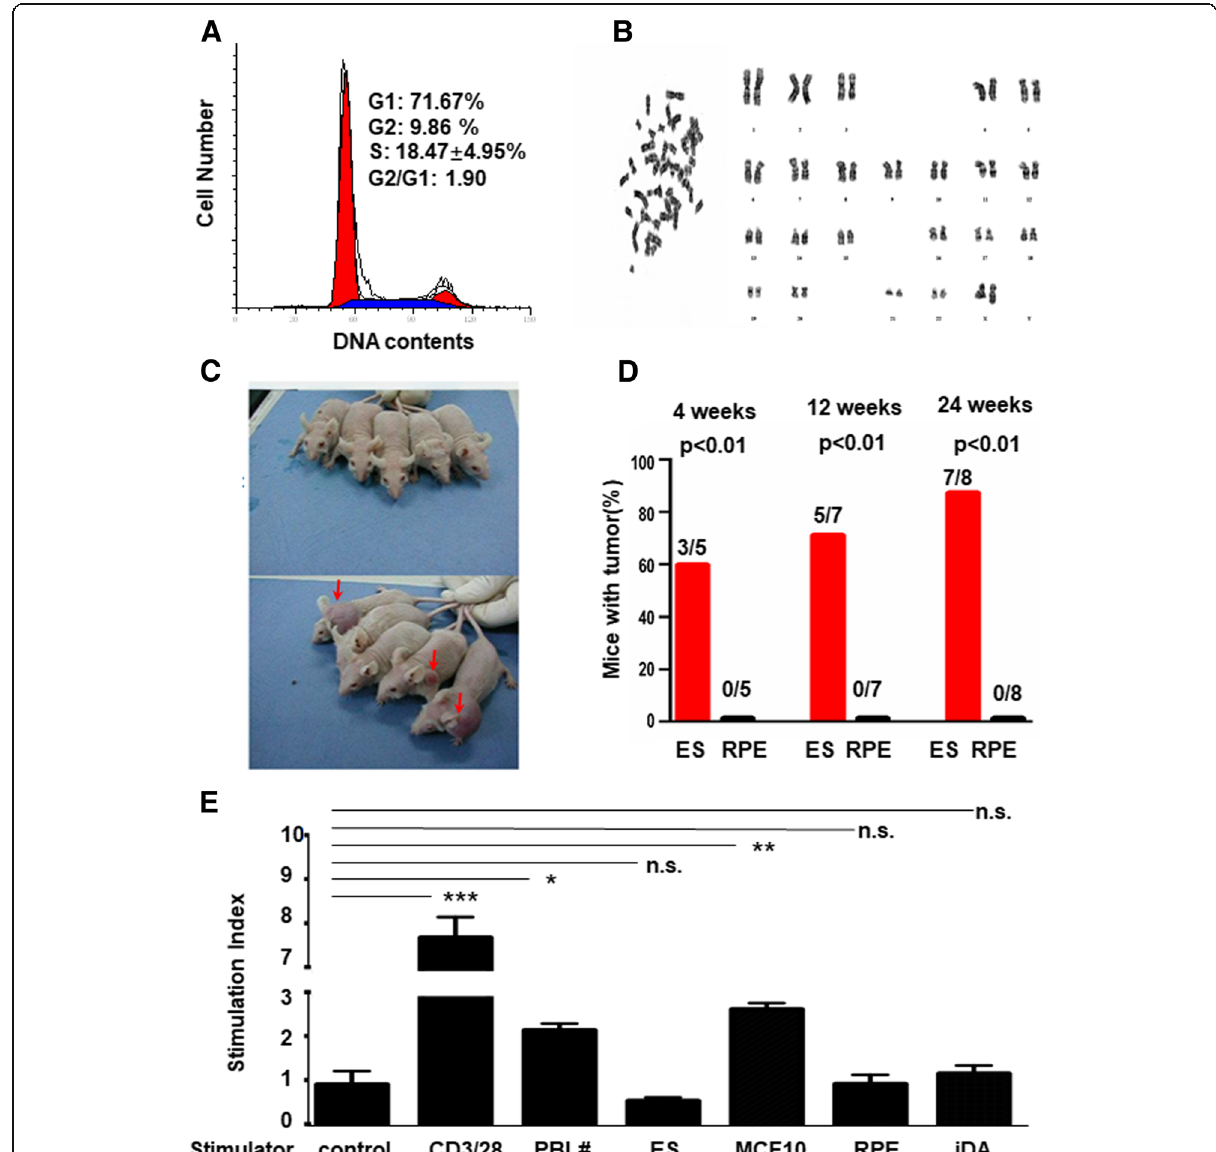
Fig. 2 Evaluation of the safety and immunogenicity of cultured RPE cells. a Representative cell cycle progression of the P20 passage of RPE cells. b Representative G-banding analyses of karyotype for P20 passage RPE cells. c A picture of tumor formation in SCID-nude mice 4 weeks after injection of RPE (top panel) and ES cells (bottom panel) ( n = 5 animals for each condition) Mice with tumors were arrowed (bottom panel). d Statistical analysis of the percentage of SCID-nude mice with tumors that formed from the ES and RPE cells measured at 4 ( n = 5 animals for each condition), 12 ( n = 7 animals for each condition), and 24 ( n = 8 animals for each condition) weeks after injection. e Measurement of hPBL to co-cultured CD3/28, mismatched individual hPBL, ES, MCF10A, RPE, and iDA by one-way mixed lymphocyte reaction. The results were presented as a stimulation index. p values were determined using one-way ANOVA. Data are expressed as mean+SD; * p <0.01, ** p <0.001, *** p <0.0001 n.s.,